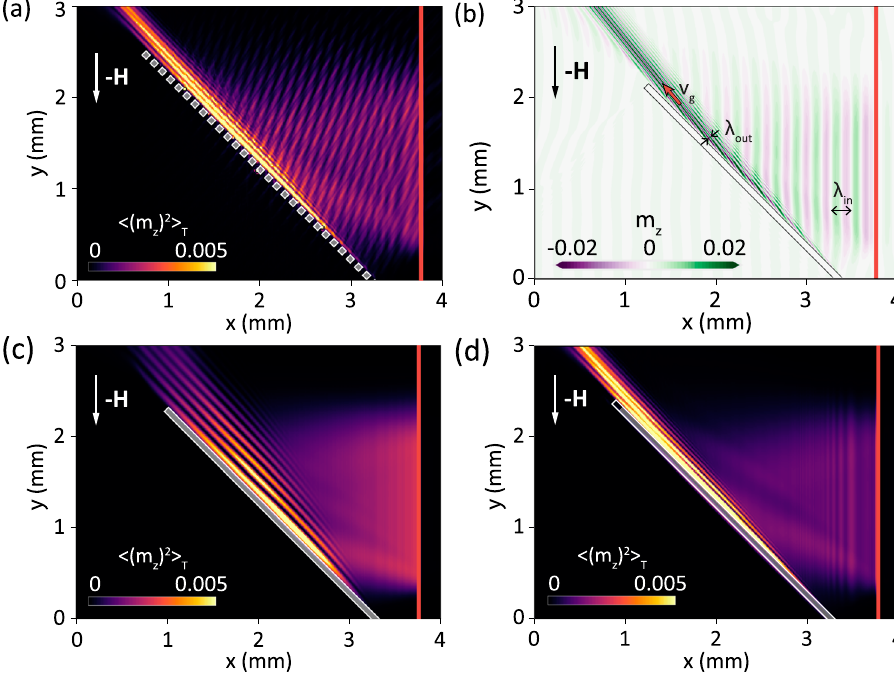
Figure 6. Results of MSs showing SWs interaction with: ( a ) antidots line of size 50 μ m and period a = 100 μ m at 4.7 GHz, ( b ) long rectangular hole (50 μ m width) at 4.7 GHz, ( c ) long rectangular hole (50 μ m width) at 4.98 GHz, and ( d ) on the area with the inhomogeneous internal magnetic field at 4.7 GHz. Note that in ( b ) SWs amplitude (i.e. the out of plane component of the reduced magnetization m z = M z /M S ) and in ( a , c ) and ( d ) SWs intensity are presented. The SWs are excited by the microstrip antenna (red rectangle) located on the right side of the antidots line and propagate on the left side of the antenna. The static magnetic field 980 Oe for ( a – d ) was oriented along the y -axis. In ( b ) we marked SW wavelengths of ingoing and outgoing SWs and group velocity of the outgoing SW